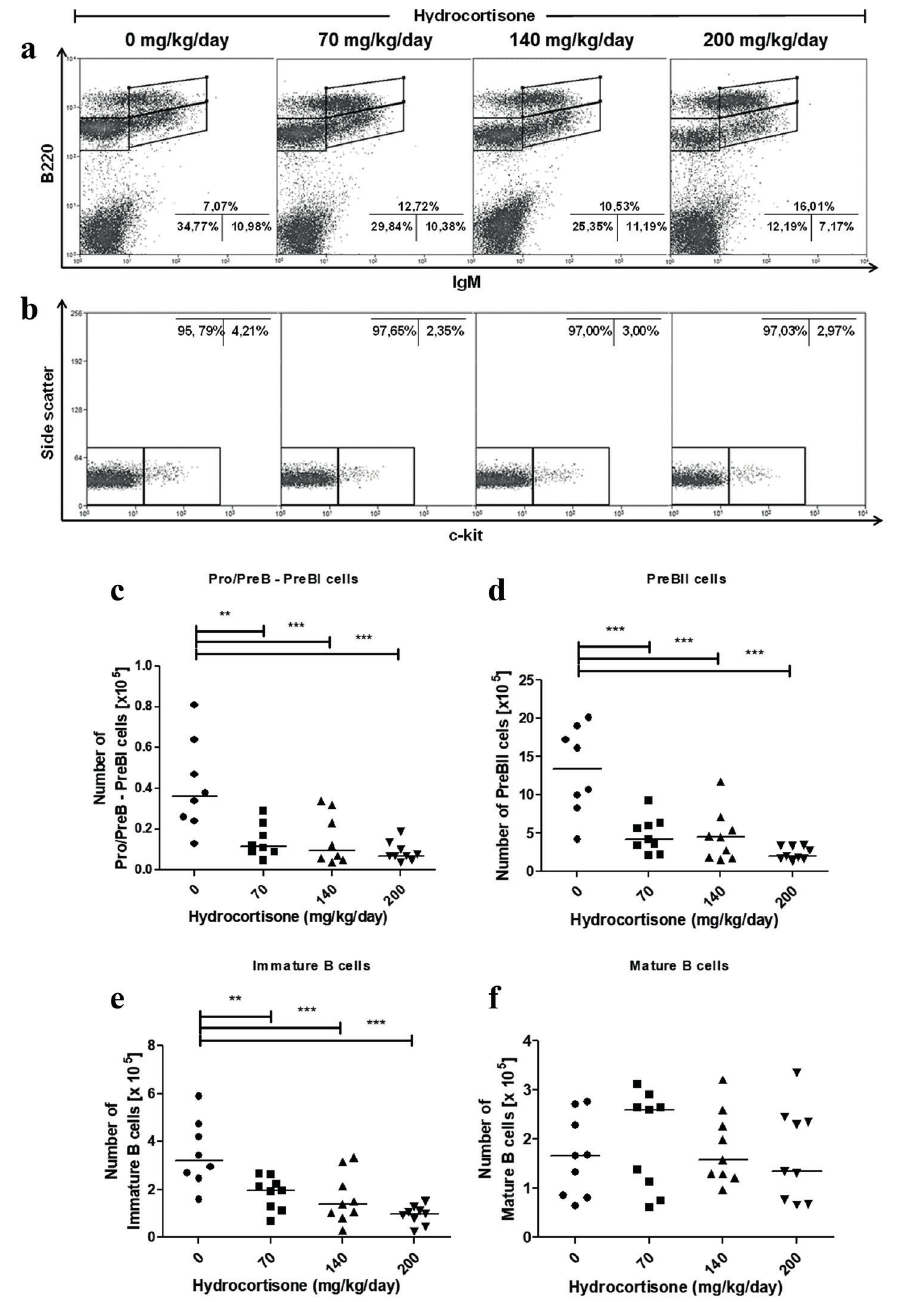
Figure 3 - Effect of in vivo treatment with hydrocortisone on subsets of bone marrow B cells. Mice were injected with diluent or hydrocortisone (70, 140 or 200 mg/kg/day) for 3 consecutive days. In the next day, bone marrow cells were counted and stained with monoclonal antibodies for c-kit, B220 and IgM molecules for analysis by flow cytometry. ( a ) Percentage of Pro/PreB-PreBII (B220+IgM-), immature B (B220lowIgM+) and mature B cells (B220highIgM+), ( b ) percentage of Pro/PreB-PreBI (c-kit+) and PreBII (c-kit-), derived from Pro/PreB-PreBII subset, ( c ) total number of Pro/PreB- PreBI, ( d ) PreBII, ( e ) immature B and ( f ) mature B cells . Line represents the median, (**) represents values of p<0.01 and (***) p<0.001, according to the statistical test. Results are representative of 3 independent experiments with 3 mice/group